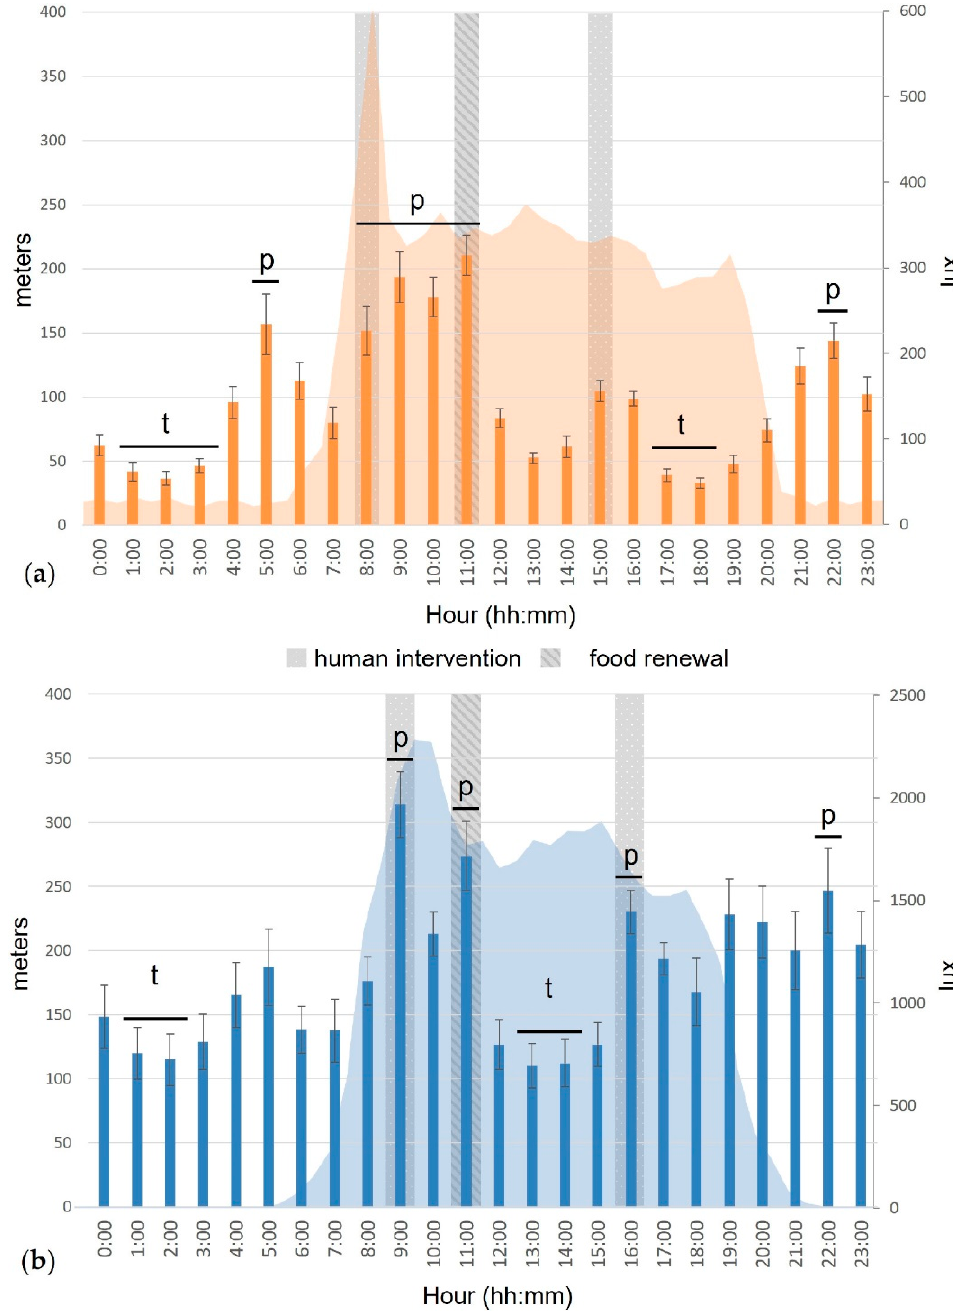
Figure 6. Mean covered distance (m, bars) and luminosity (lux, area) during a day cycle of the cats, indoors ( a , n = 15) and outdoors ( b , n = 8). Error bars represent standard errors, (p) indicates a significant peak, (t) indicates a significant trough (for more details, see [29]). The outdoor cats covered significantly more distance than the indoor cats on several occasions during the day and especially during the evening and night (Figure 7).